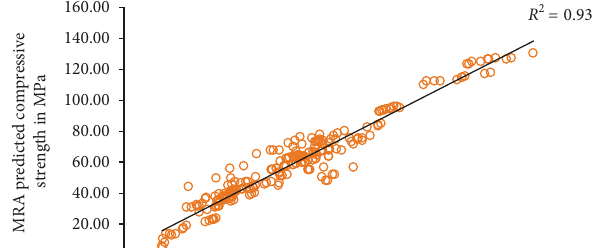
Figure 4: Actual vs. ANN predicted value for split tensile R 2 = 1